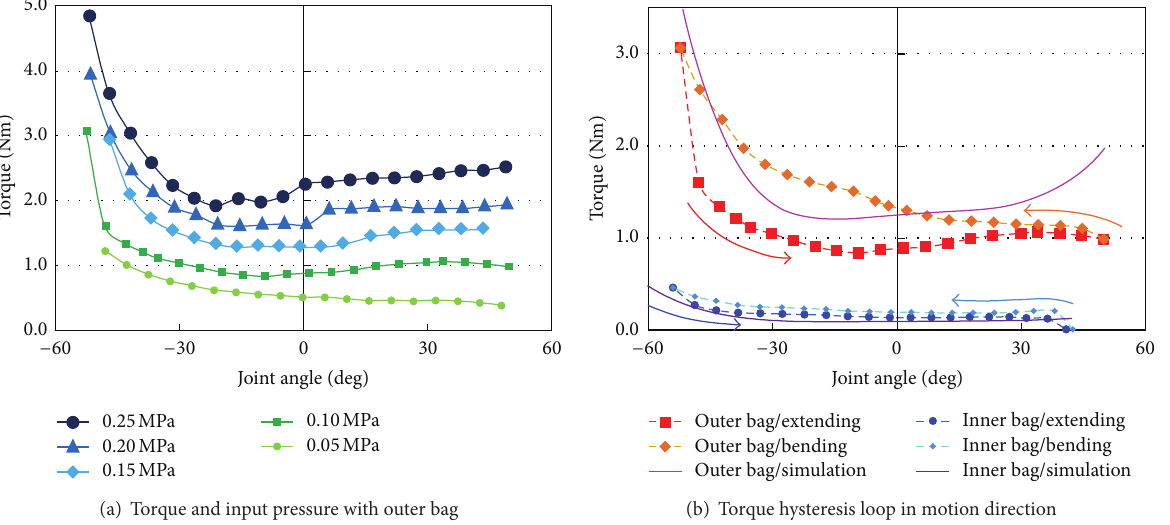
Figure 14: Result of torque